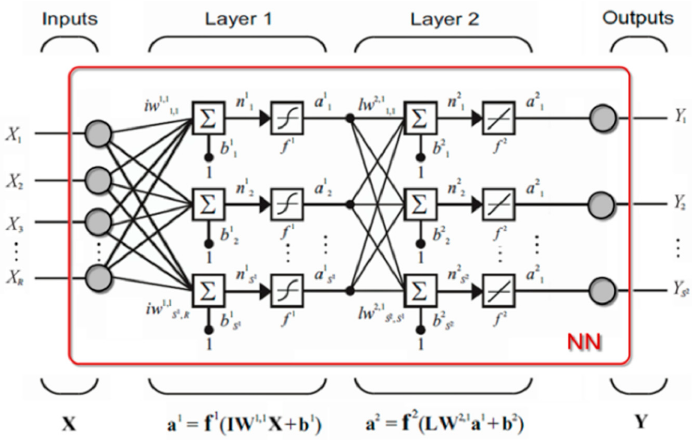
Figure 1. Schematic showing the NN architecture connecting the input and outputs parameters [66].